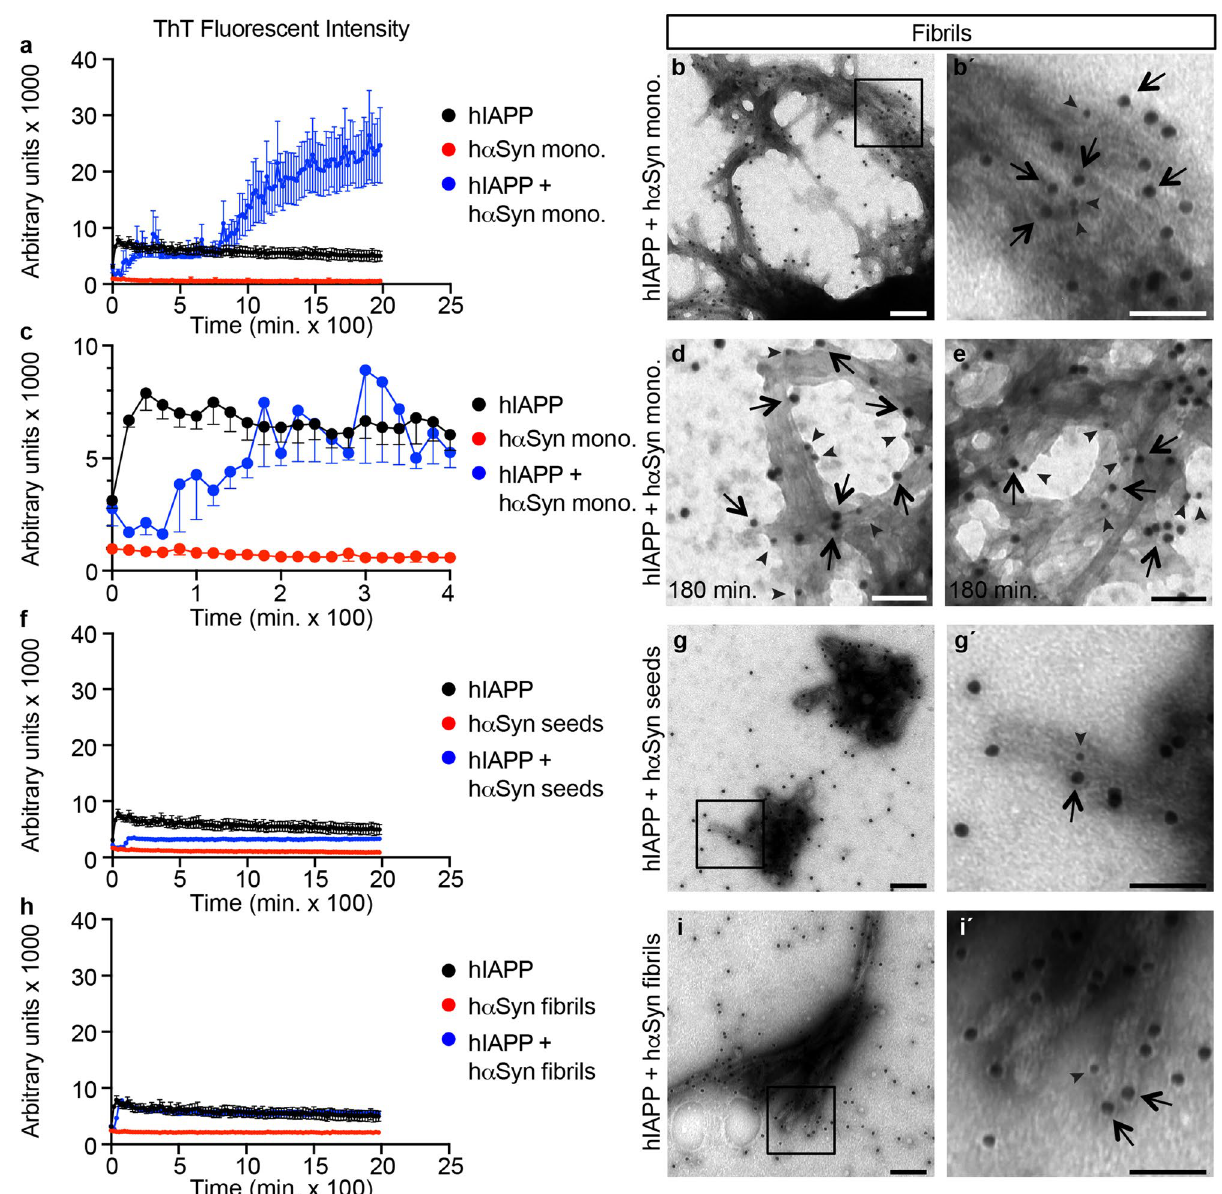
Figure 2. α-Syn monomers cross-seed IAPP fibril formation. ( a, c ) Fibril formation ThT curves for the entire 2000 min incubation period ( a ) and a close up of the first 400 min ( c ) for 2 µM hIAPP monomers alone (black), 7 µM hαSyn monomers alone (red), and 2 µM hIAPP monomers with 7 µM hαSyn monomers (blue). ( b,b’,d,e ) TEM images of immuno-gold labelling for αSyn (sc-7011R, 15 nm gold particles) and IAPP (NBP1- 06579, 10 nm gold particles) of the resulting fibrils at 2000 min ( b,b’ ) and at 180 min ( d,e ) from incubating 2 µM hIAPP monomers with 7 µM hαSyn monomers. ( b’ ) show marked area (open square) in ( b) in higher magnification. ( f,h ) Fibril formation ThT curves for 2 µM hIAPP monomers alone (black in f,h ), 7 µM hαSyn seeds alone (red in f ), 7 µM hαSyn fibrils alone (red in h ), and 2 µM hIAPP monomers with 7 µM hαSyn seeds (blue in f ) and 7 µM hαSyn fibrils (blue in h ), respectively. ( g,g’,i,i’ ) TEM images of immuno-gold labelling for αSyn (sc-7011R, 15 nm gold particles) and IAPP (NBP1-06579, 10 nm gold particles) of the resulting fibrils (end-stage) from incubating 2 µM hIAPP monomers with 7 µM hαSyn seeds ( g ) and fibrils ( i ), respectively. ( g’,i’ ) show marked areas (open square) in ( g ), and ( i), respectively, in higher magnification. Black arrows indicate αSyn and arrow heads indicate IAPP labelled gold particles. Data in (a,c,f,h) are presented as mean value + /− SEM. Scale bar is 200 nm in ( b,g,i) and 100 nm in ( b’,d,e,g’,I’)